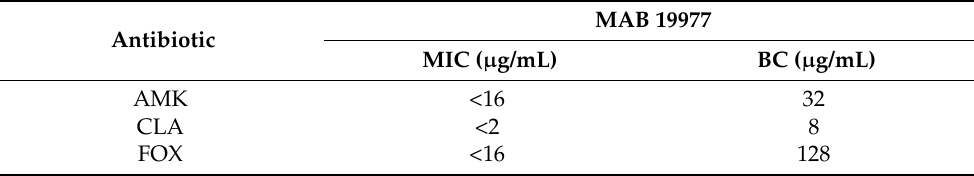
Table 1. Antibiotic concentrations used in the MAB mutant library susceptibility